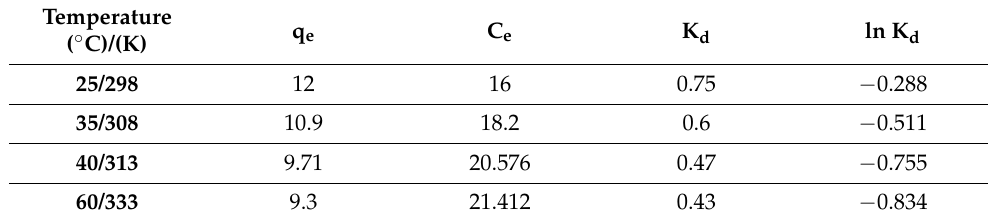
Table 7. The values used in the calculation of thermodynamic parameters and constants.